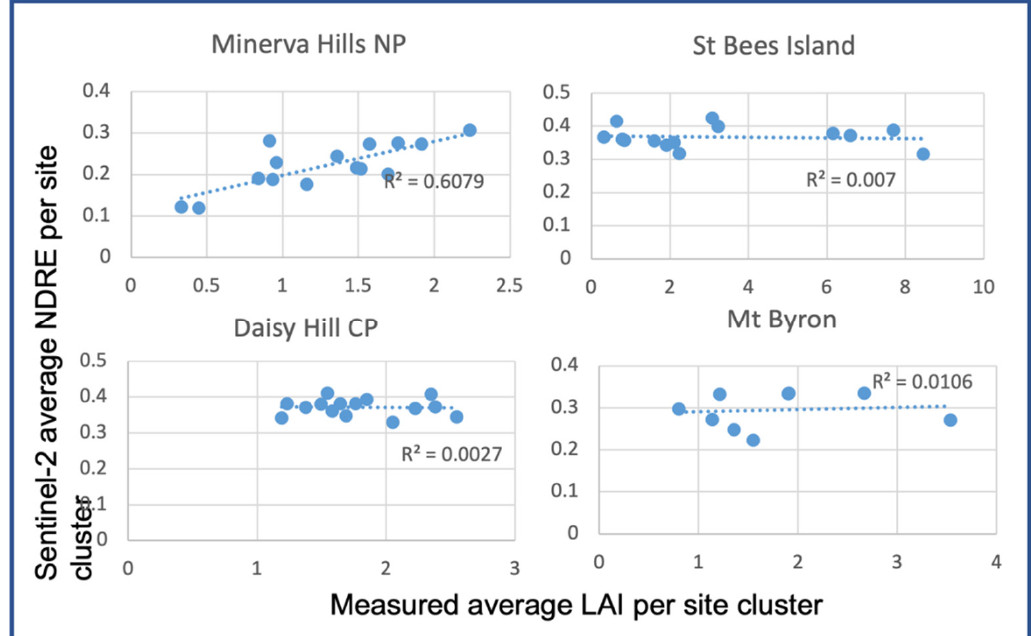
Figure A5. Comparing field measured and Sentinel-2 clusters NDRE.